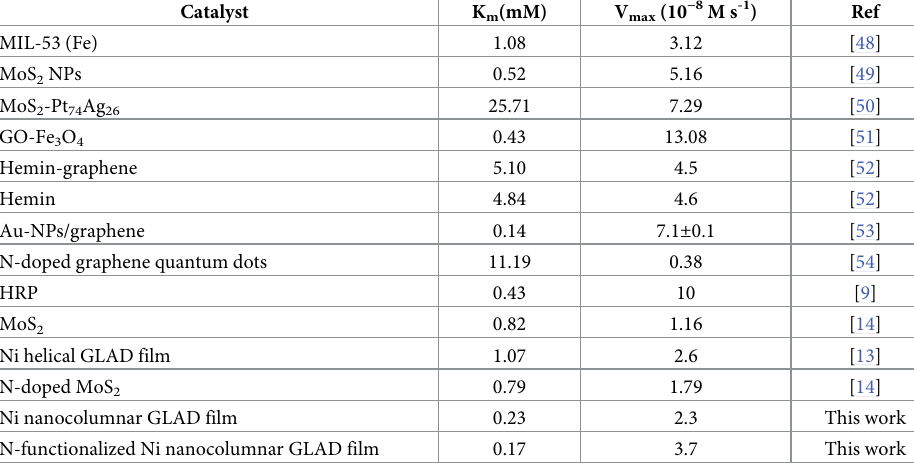
Fig 6. TMB conversion rate vs TMB concentration. (a) pristine Ni film, and (b) NH 3 plasma modified Ni film for 120s. https://doi.org/10.1371/journal.pone.0257777.g006 Table 2. K m values for different peroxidase-mimicking